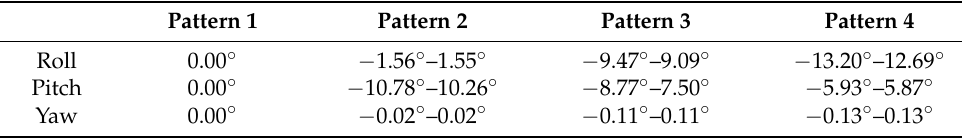
Table 4. Motion of the simulated high-speed